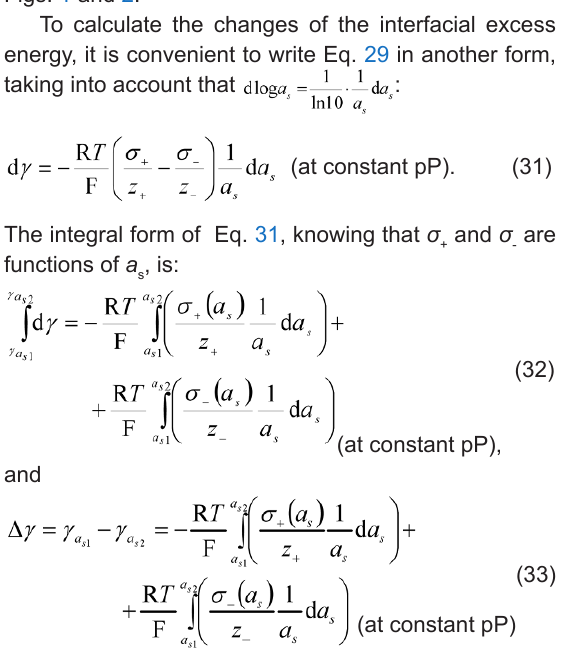
Figure 1. Influence of NaCl activity on ionic components of charge for TiO2 at selected pH values. Numerical values taken from Sprycha et al. [19]. Due to lack of s - for 0.001 M NaCl solutions in the paper, values of s - were assumed to be the same as – s + for pH equally distant from the pzc. In the original paper s - values were plotted as negative numbers without marking them as negative on the y axis.